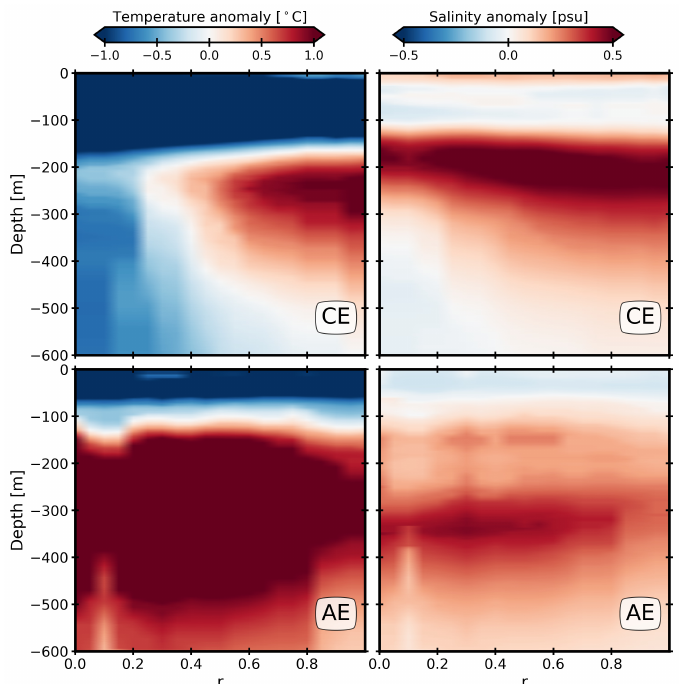
Figure 7. The 3D structure of the AE and CE temperature anomaly and salinity anomaly for a grid of depth and the location of the ARGO floats inside the eddies. These anomalies are smoothed using a median filter of a kernel size of